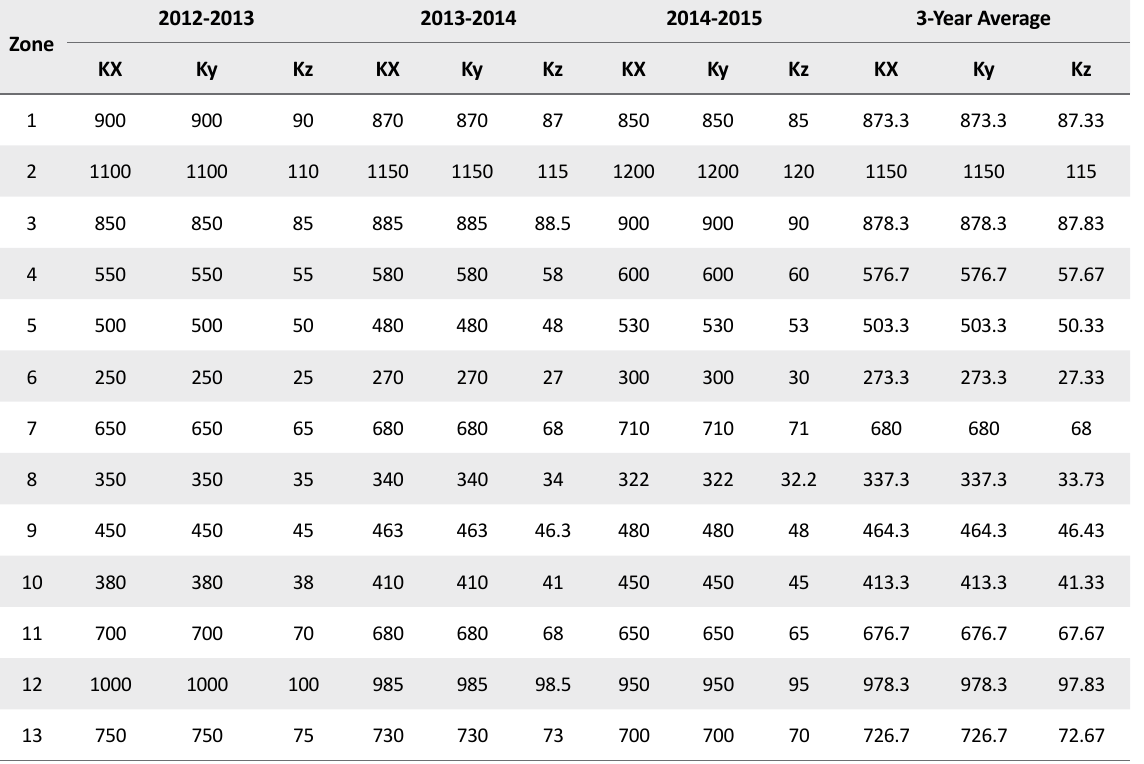
Table 4. Hydraulic conductivity coefficient obtained by calibration of different years and final values (m/d)